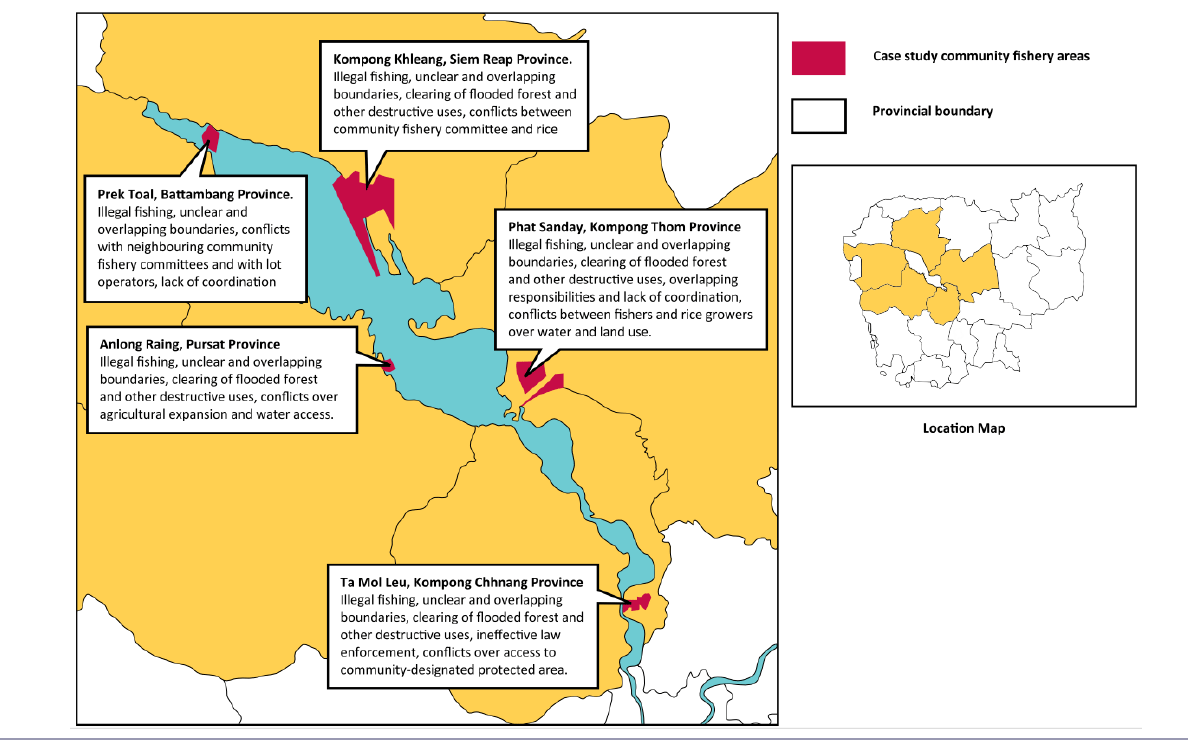
Fig. 2 . Tonle Sap Lake, showing local case study sites and key